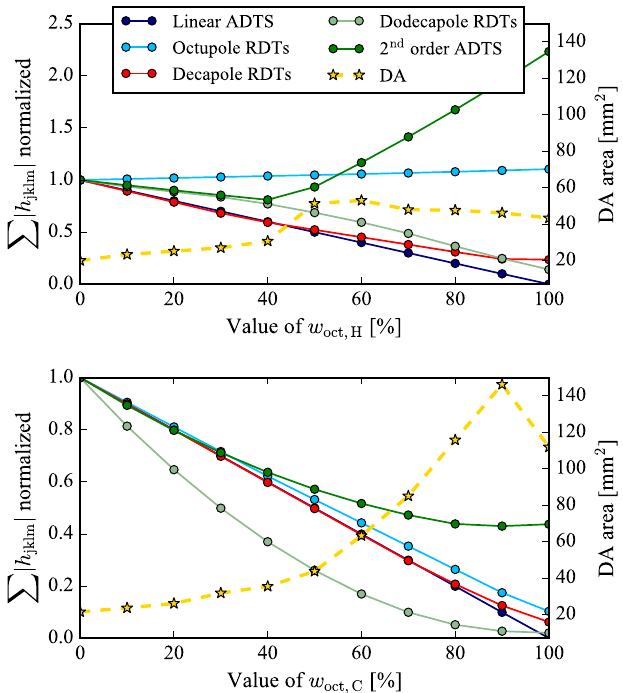
.FIG. 6. Sum of the geometrical RDT amplitudes computed with MADX - PTC [20] after one turn for each the fourth-, fifth-, and sixth-order contributions, as function of the weight factor w . oct The values are normalized to the sum contributions of the sextupoles only. The phase and amplitude dependent terms are summed separately in order to distinguish the contribution of the linear and second-order ADTS. The on-momentum DA area is computed after 1024 turns using the ELEGANT [23] tracking code. The top plot shows the case using oct triplet. The bottom plots H shows the case using oct triplet where the contribution of all C phase and amplitude dependent terms simultaneously decrease with w oct